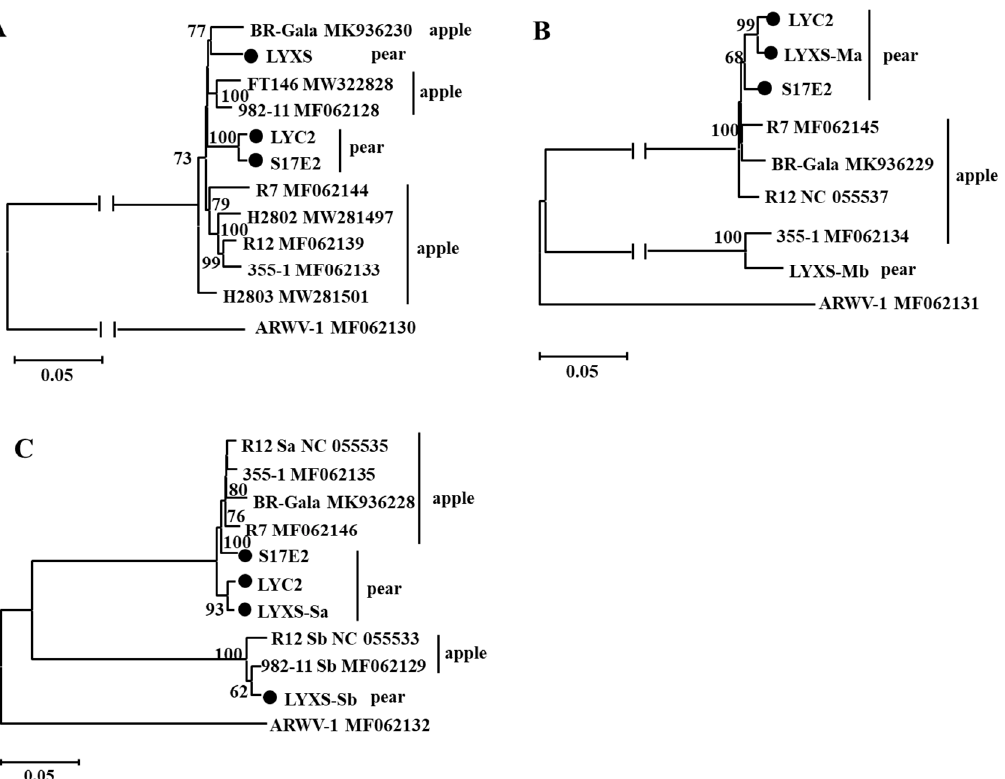
Figure 2. Unrooted NJ phylogenetic trees generated from the nucleotide sequences of L ( A ), M ( B ) and S ( C ) RNA segments of ARWV-2. In the trees based on M ( B ) and S ( C ) segment sequences, Ma and Mb, and Sa and Sb sequences from pear LYXS and the two reported isolates were included in the assay. The corresponding sequence of a reported ARWV-1 isolate was used as an outgroup in each tree. The referred sequences are marked by their isolate names followed by GenBank accession numbers. Three ARWV-2 isolates determined by high throughput sequencing are highlighted by black dots.